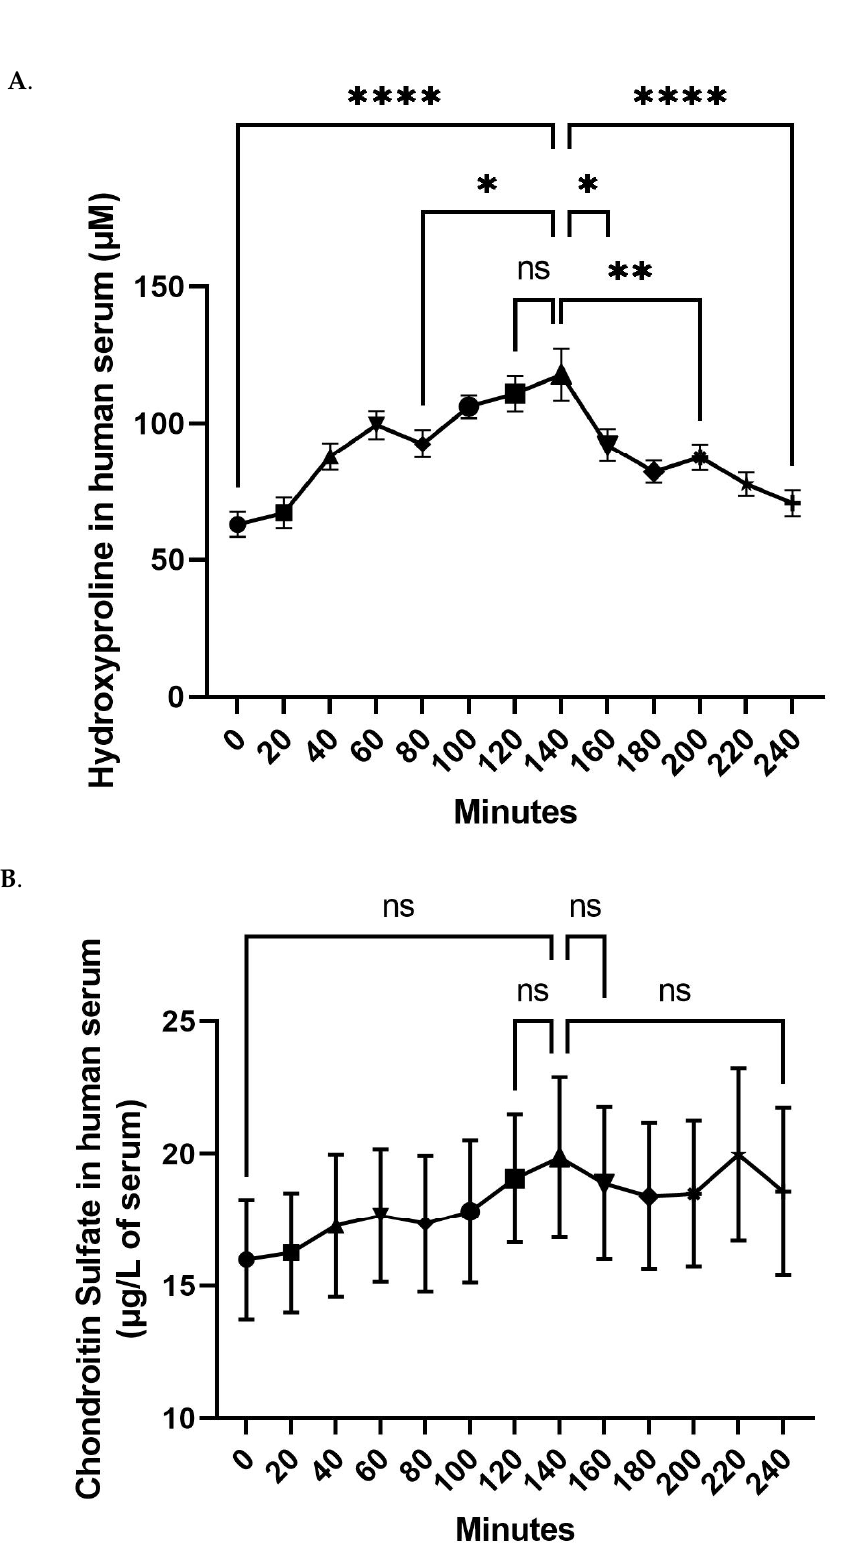
Figure 2. Evolution of the concentration of the circulating hydroxyproline ( A ) and chondroitin sulfate ( B ) in blood. Values are presented as the means ± SEM. The differences were considered statistically significant at p < 0.05 with * for p < 0.05; ** for p < 0.01; **** for p < 0.0001 and ns for p > 0.05.